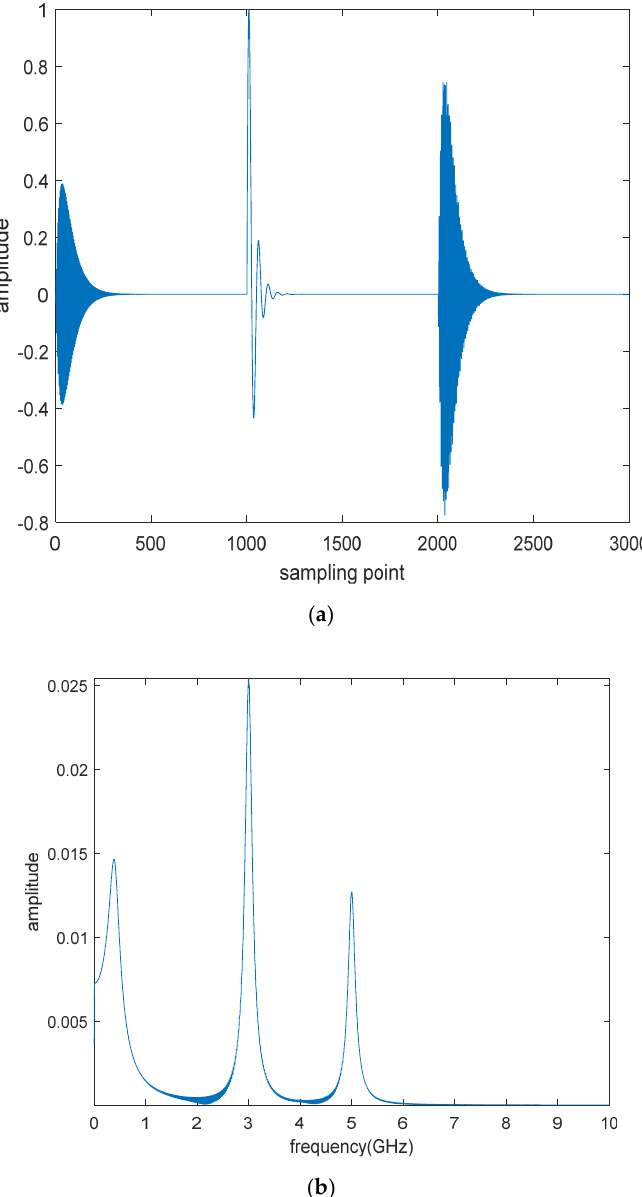
three types of PD signals are directly obtained by assigning different parameters to s 1 and s 2 . They are denoted as PD1 to PD3, respectively, with their parameters shown in Table 1. A more complex PD signal is then synthesized by the normalized combination of PD1 to PD3, i.e., PD = [PD3, PD1, PD2], and the peak amplitude of PD is normalized to be 1. Pure PD in time domain and frequency domain are shown in Figure 3a,b.